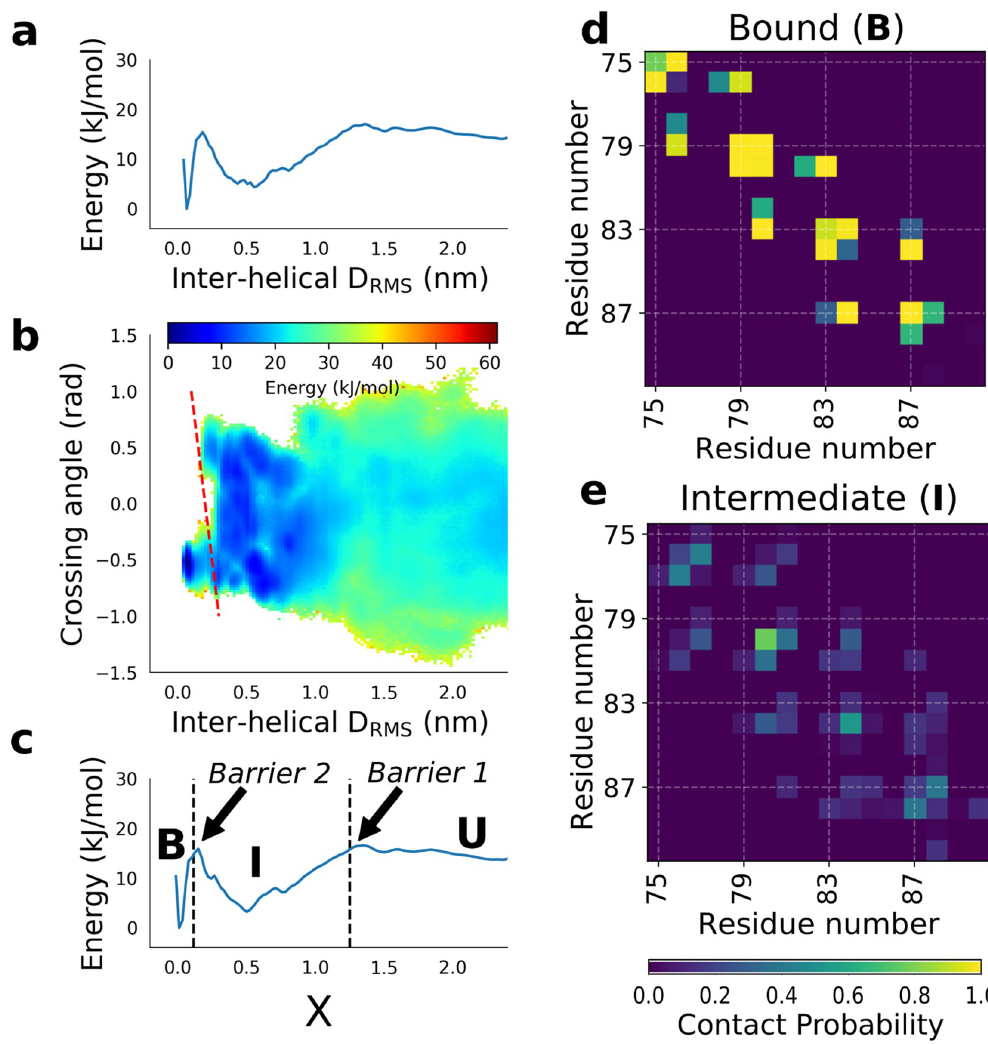
Fig 2. Binding free energy surfaces. (a) PMF projected onto the D RMS coordinate used for original umbrella sampling. (b) 2D PMF projected onto helix-helix crossing angle and inter-helical D RMS . The approximate locus of the second barrier is indicated by a dashed red line. (c) PMF projected onto the hybrid collective variable X , with first and second barriers marked by black dashed lines. Contact maps for (d) the bound native state, B, and (e) bound non-native (intermediate) states,